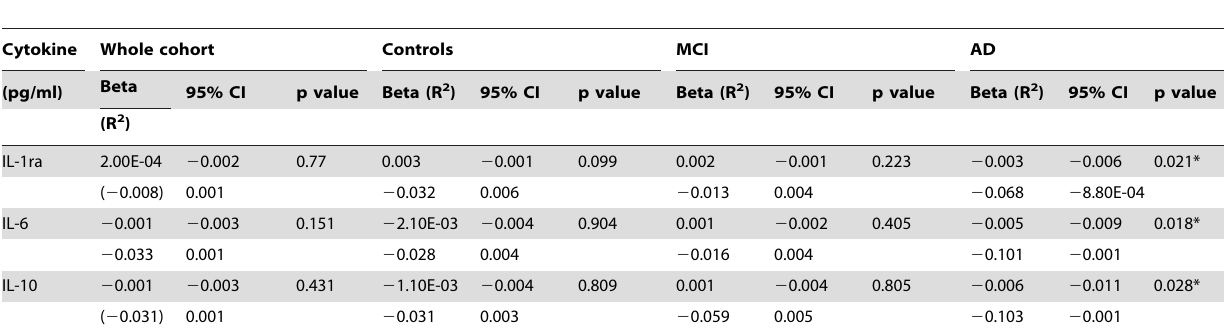
Table 3. Summary statistics for the multiple linear regression model assessing the relationship between inflammatory proteins and ventricular